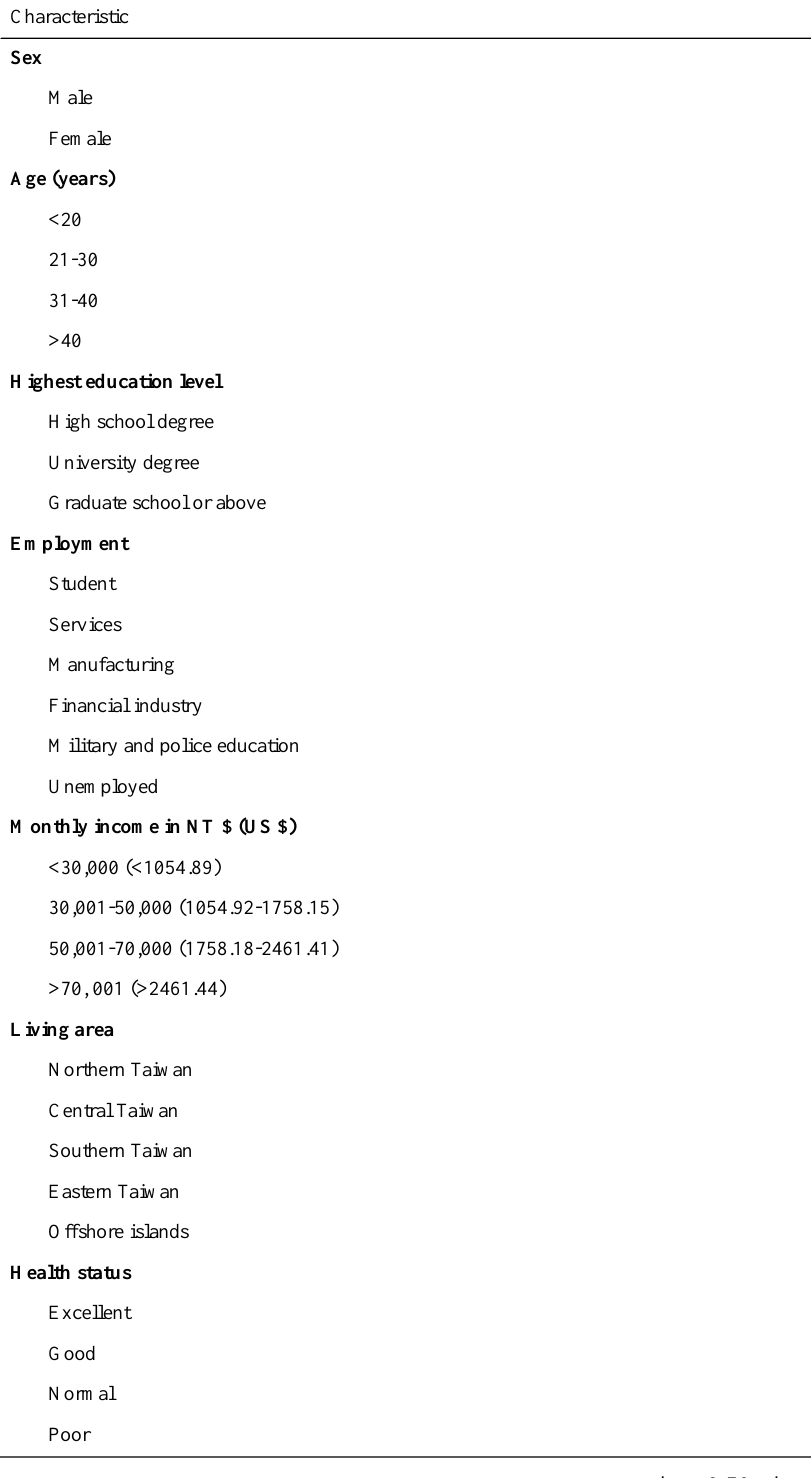
Table 2. Characteristics of the respondents